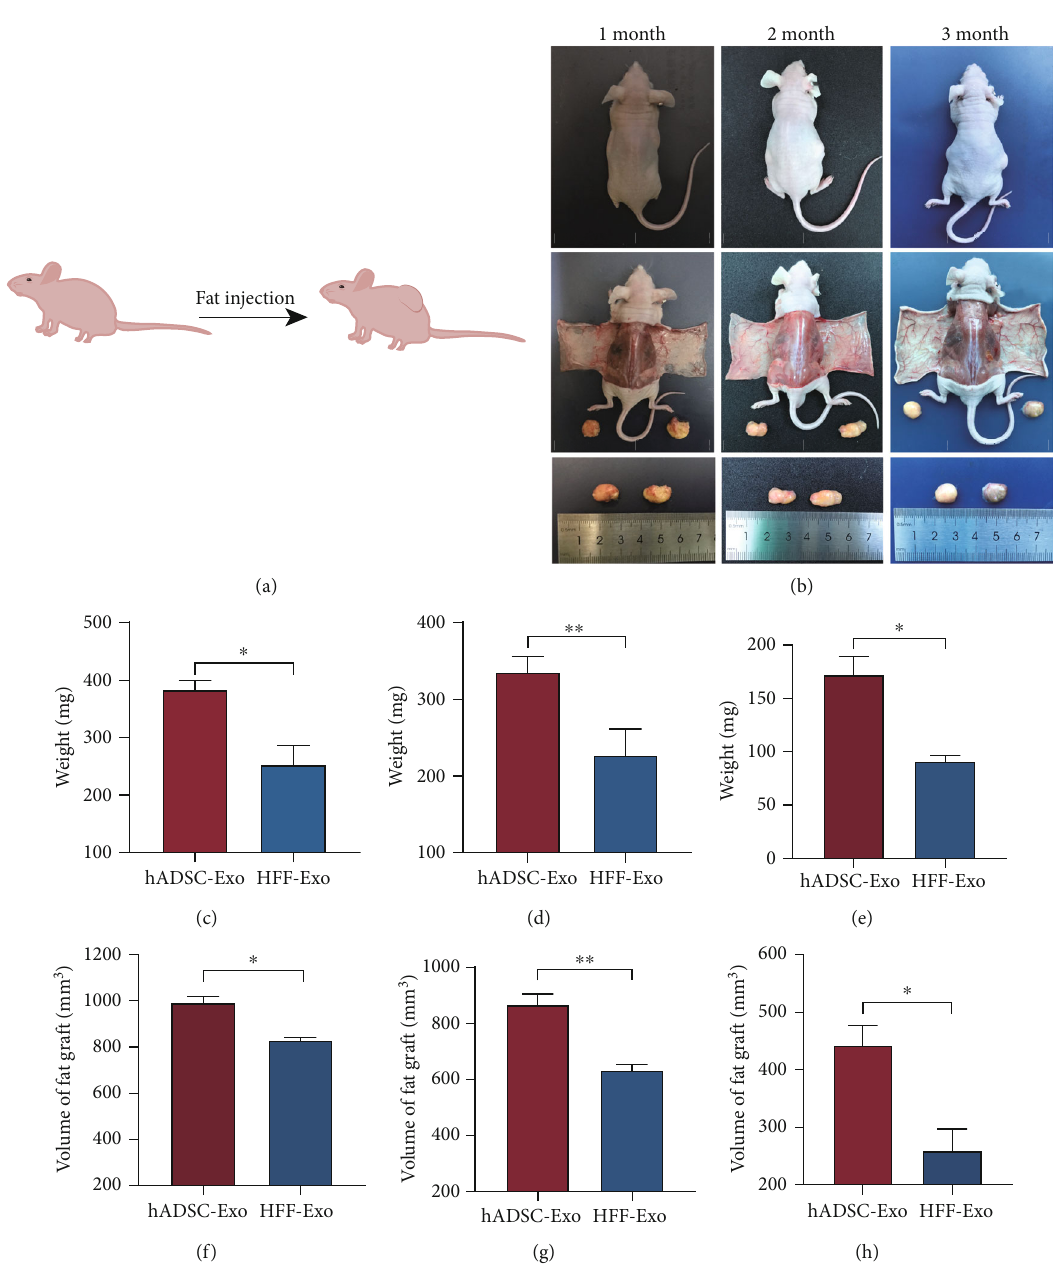
Figure 2: hADSC-Exo enhanced the survival rate of fat grafts in the nude mouse model. (a) The design of the nude mouse model. (b) Gross observation of the fat grafts demonstrated that the hADSC-Exo group (the right side of each picture) had larger graft sizes compared with that in the HFF-Exo group (the left side of each picture). (c – f) Harvesting the fat grafts at 1, 2, and 3months after fat transplantation, the weight and volume of fat grafts were signi fi cantly better in the hADSC-Exo group compared to the HFF-Exo group ( ∗ p < 0 : 05 , ∗∗ p < 0 : 01 , and ∗∗∗ p < 0 : 001